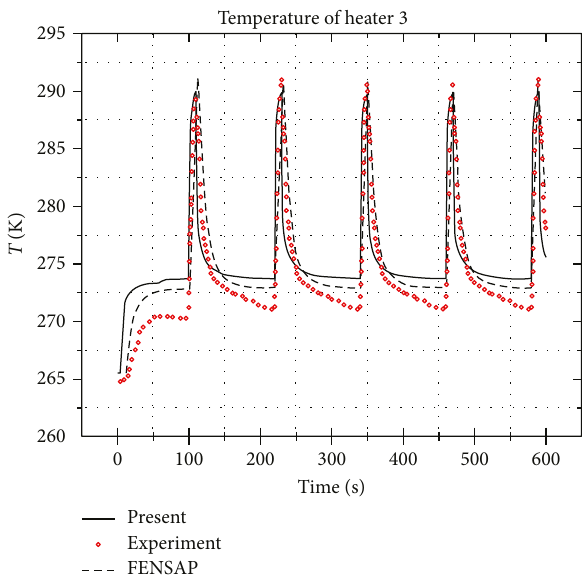
Figure 8: Comparison of temperature of heater 3.